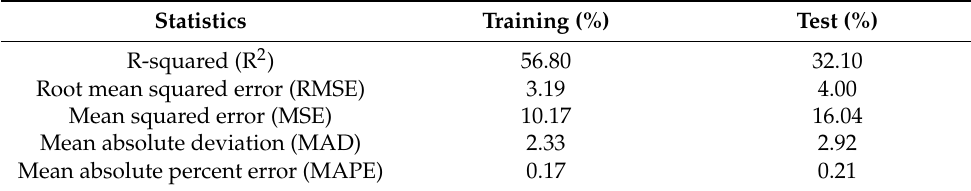
Table 7. Model summary for predicting the M f using TreeNet including three